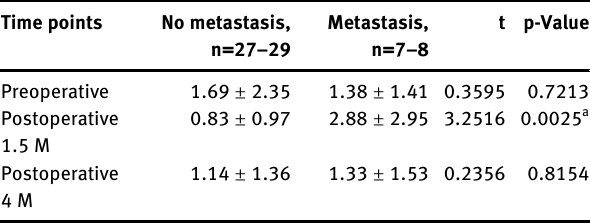
Table  : Association between mesenchymal CTC levels and post- operative metastasis.